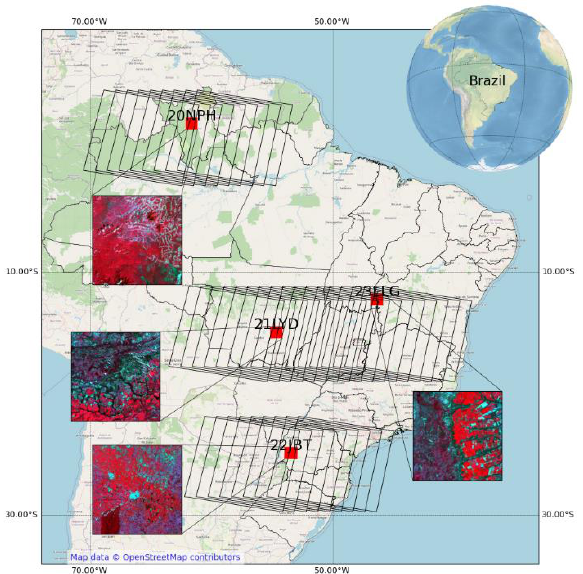
Figure 1 Location of the four MGRS tiles (red hatched) used as study sites and the WFI tiles (unfilled